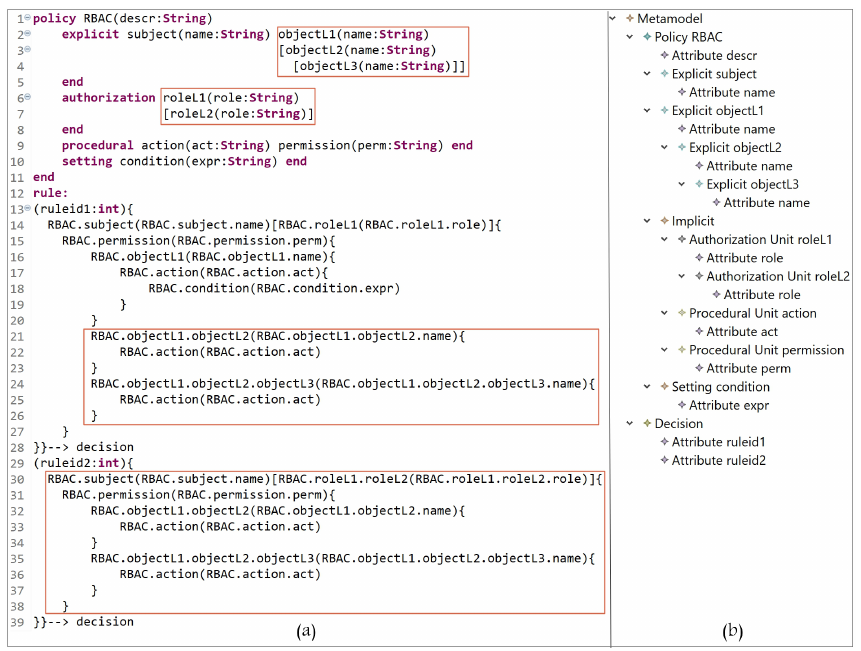
Figure 21. RBAC: ( a ) definition of role/object hierarchy; ( b ) hierarchy of role/object